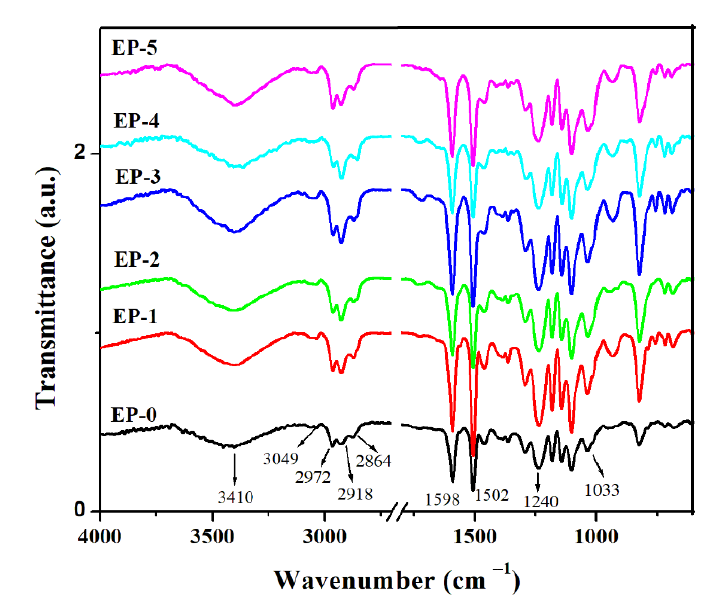
Figure 3. FTIR spectra of epoxy thermosets.